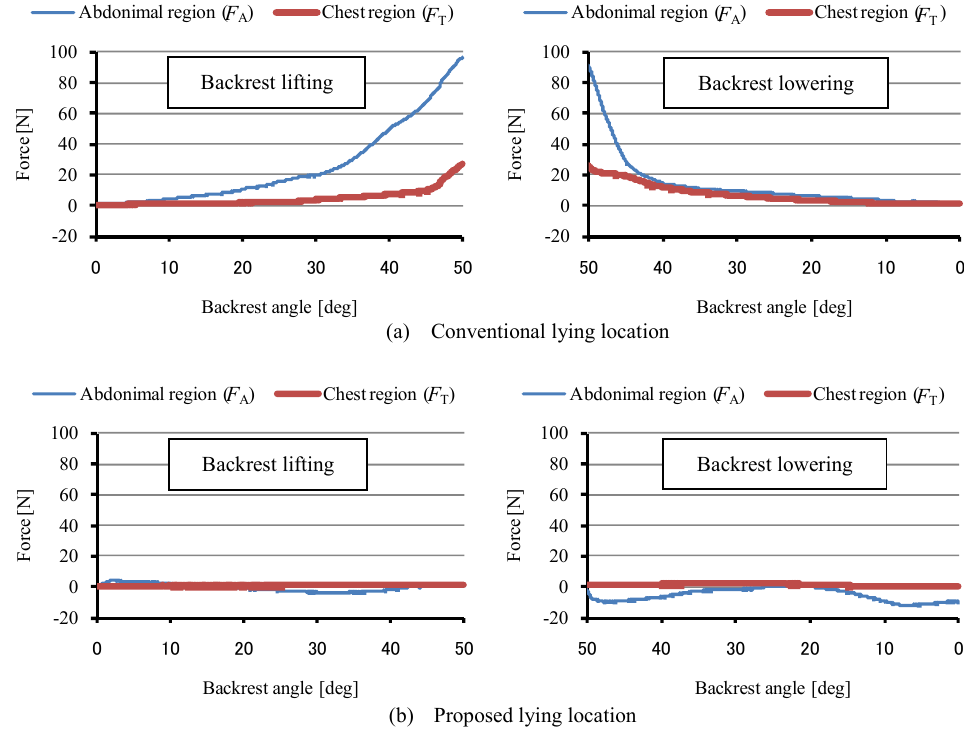
Fig. 7 Forces during backrest lifting and